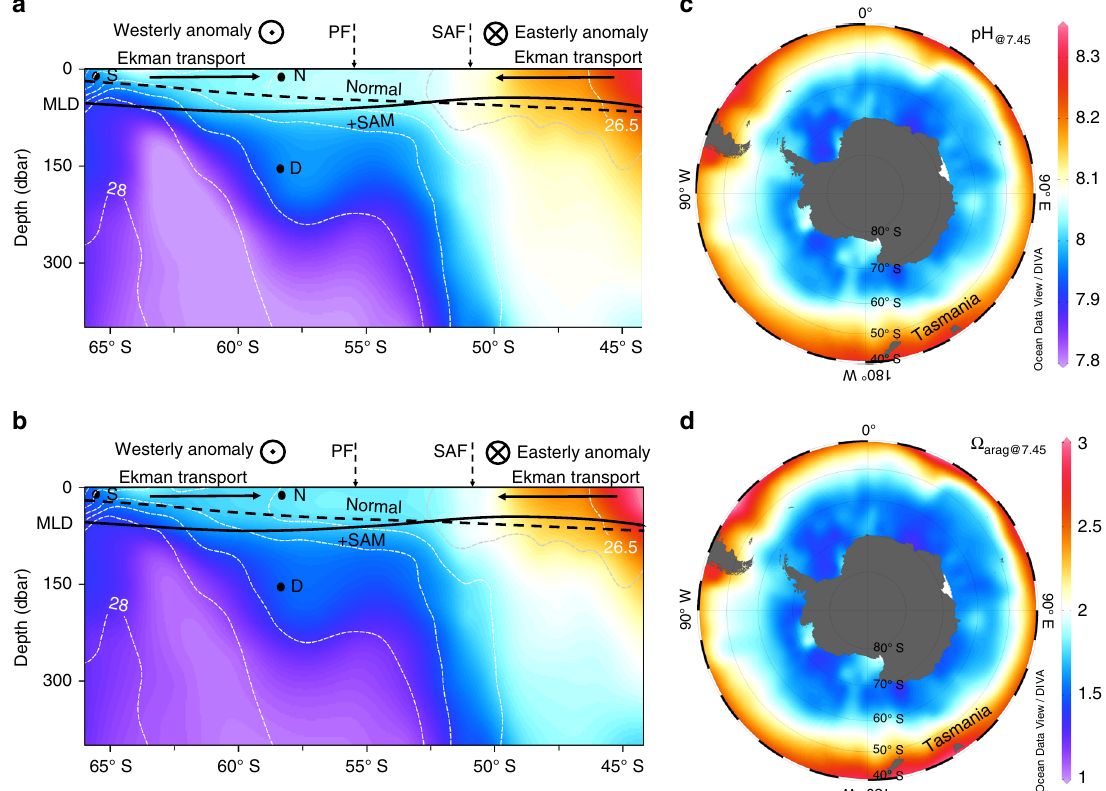
Fig. 5 A schematic of Ekman transport and vertical mixing modulation of acidi fi cation rates as well as climatological distribution of surface pH @7.45 and Ω arag@7.45 . a , b Depict changes of wind-driven Ekman transport and mixed layer depth (MLD), and their in ( b ) in the region south of Tasmania during a positive SAM trend. There will be an anomalous equatorward Ekman transport when westerly winds increase (westerly anomaly), while there will be an anomalous poleward Ekman transport when westerly winds decrease (easterly anomaly). MLD is used for showing the changes in vertical mixing in the upper ocean. Black dashed (normal) and solid ( + SAM) lines denote MLD before and during a positive SAM trend, respectively. In a , b , SAF and PF denote the mean positions of the subantarctic front (SAF) and the polar front (PF) 58 . In the water column, neutral density contours with an interval of 0.25 kg m − 3 ( γ n , white dashed line), and pH @7.45 ( a ) and Ω arag@7.45 ( b ) distribution (shaded) observed along Transect SR03 during December 1994 – January 1995 are shown. Also in a , b Points S, N, and D are shown, details about which can be found in Supplementary Table 5. In c , d , climatological distribution of surface pH @7.45 ( c ) and Ω arag@7.45 ( d ) in January calculated from the TA and DIC data of Takahashi et al. 9 is shown. Note a , c use the same color bar, and b , d use the same color bar. Figure 5 is plotted using Ocean Data View (odv_4.7.10_w64 version) 59